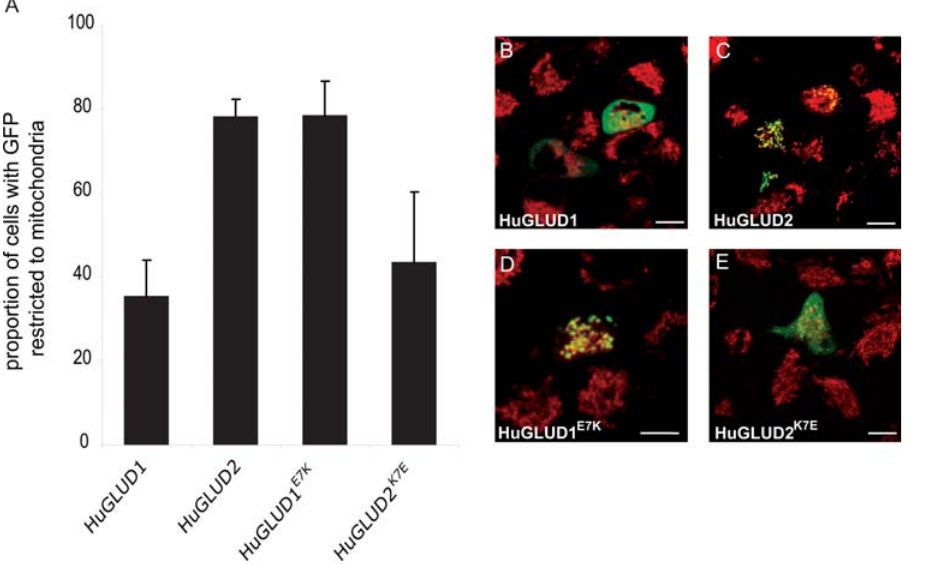
Figure 5. Subcellular Localization of GLUD1 and GLUD2 Proteins With Wild Type and Mutant MTSs, respectively. (A) Proportion of transfected HeLa cells with GLUD-GFP signals detected only in mitochondria. HuGLUD2 K7E shows significantly lower mitochondrial localization specificity than HuGLUD2 and HuGLUD1 E7K ( P , 0.01, Tukey’s Post Hoc test). (B)–(E) HeLa cells transfected with wild type and mutant GLUD proteins (mitochondria labeled with MitoTracker, red). Scale bars=10 m m. Unmerged images are shown in Figure